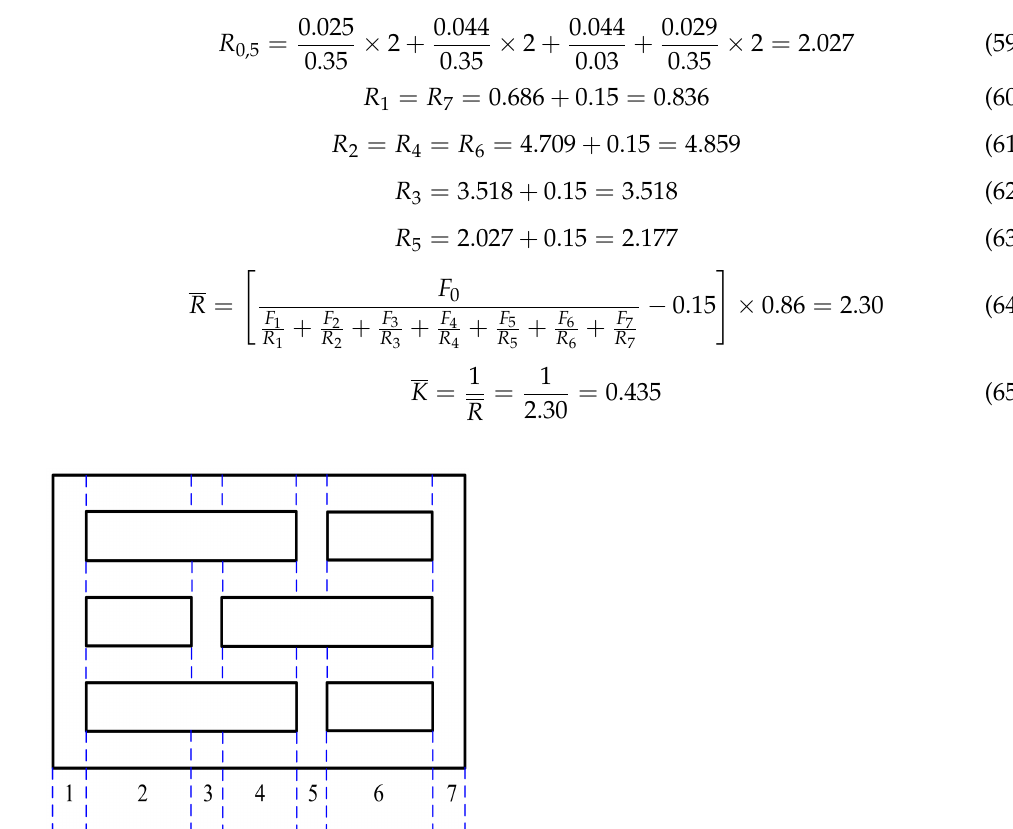
Figure 11. Division diagram of the heat transfer channels. Based on the above calculation, the average heat transfer coefficient of AASCCIB A 1 was 0.435 W/(m 2 · K). In addition, using the above calculation method, the average heat transfer coefficients of AASCCIBs A 2 , B 1 , B 2 , C 1 , and C 2 were 0.444, 0.424, 0.448, 0.434, and 0.442 W/(m 2 · K).